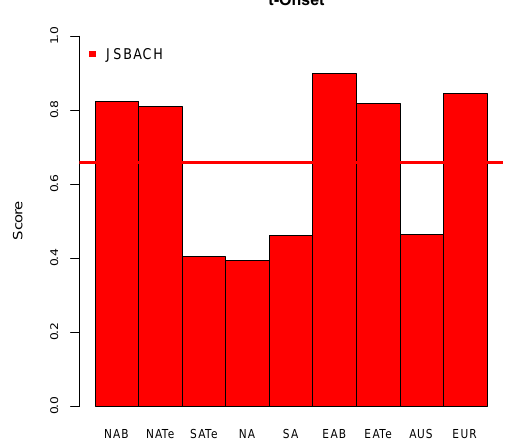
Fig. A3. Final score of the time of onset trait computed according to Transcom3 land regions. (Tropical Asia and South American Trop- ical). The horizontal line represents the mean of the regional